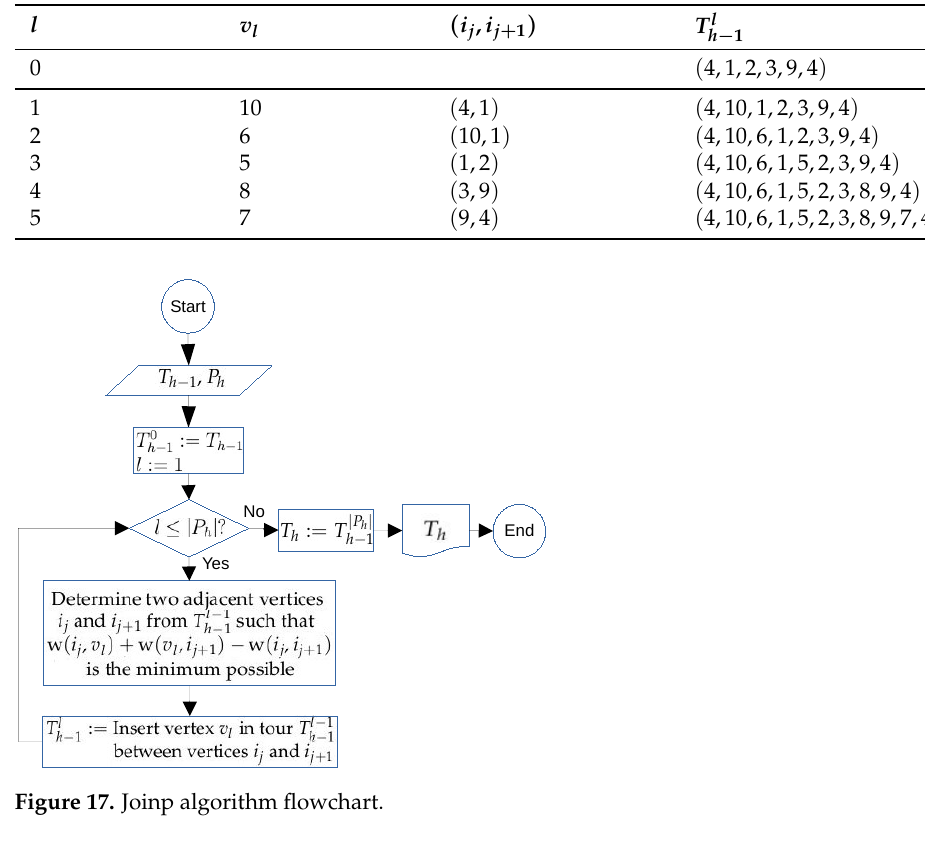
Table 3. Iterations performed by Algorithm 4 ( JOINP ) for the construction of tour T 2 .